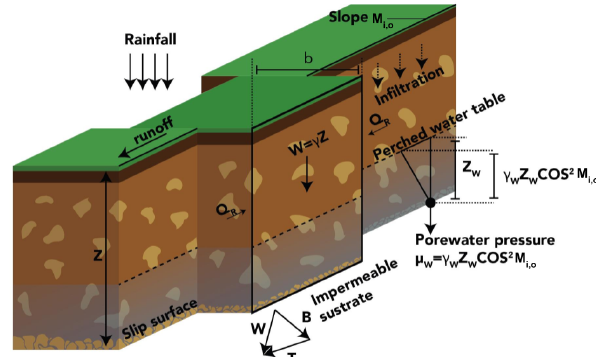
Figure 7. Schematic diagram of the landslide submodel. The figure and description are adapted from Aristizábal et al. (2016). Q L and Q R are the resultant forces on the sides of the slice of